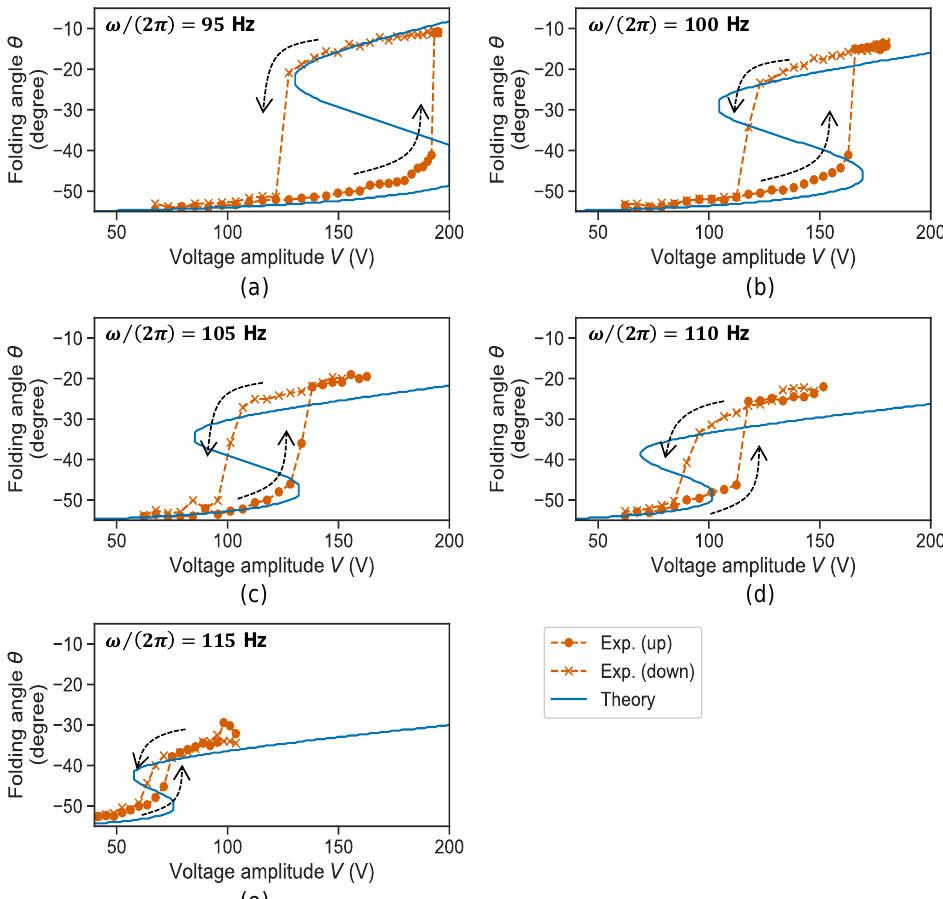
Figure 7. Comparison between experimental and theoretical results with frequencies of ( a ) 95 Hz,